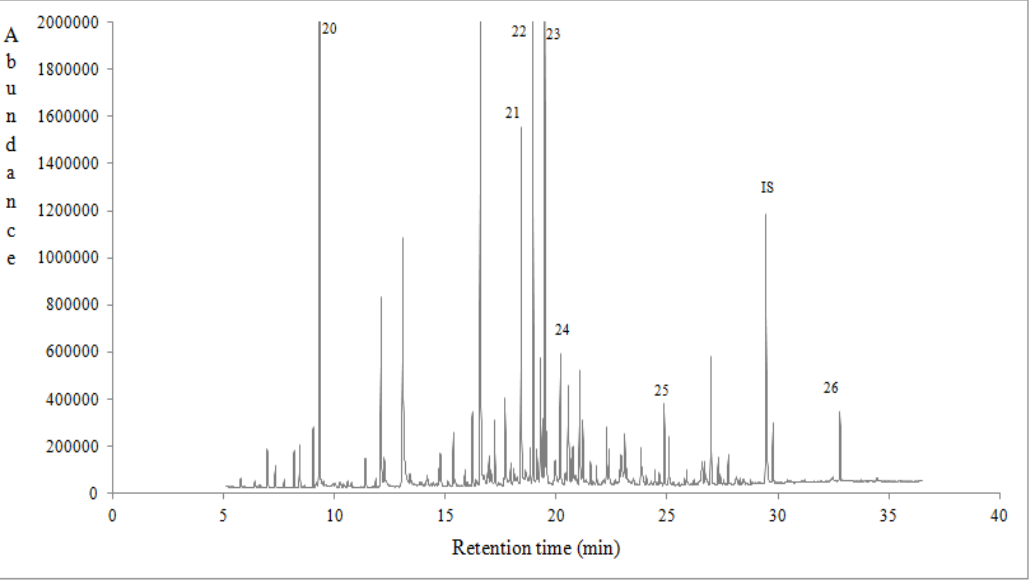
Figure 3. A typical gas chromatogram of heather honey from the region of Coimbra, Vila Nova de Ceira, in Portugal. 20: Heptane. 21: Benzeneacetaldehyde. 22: cis-Linalool oxide. 23: Hotrienol. 24: alpha-Isophorone 25: 1,2-dihydro-1,1,6-trimethyl-Naphthalene. 26: Eicosane. IS: Internal standard.